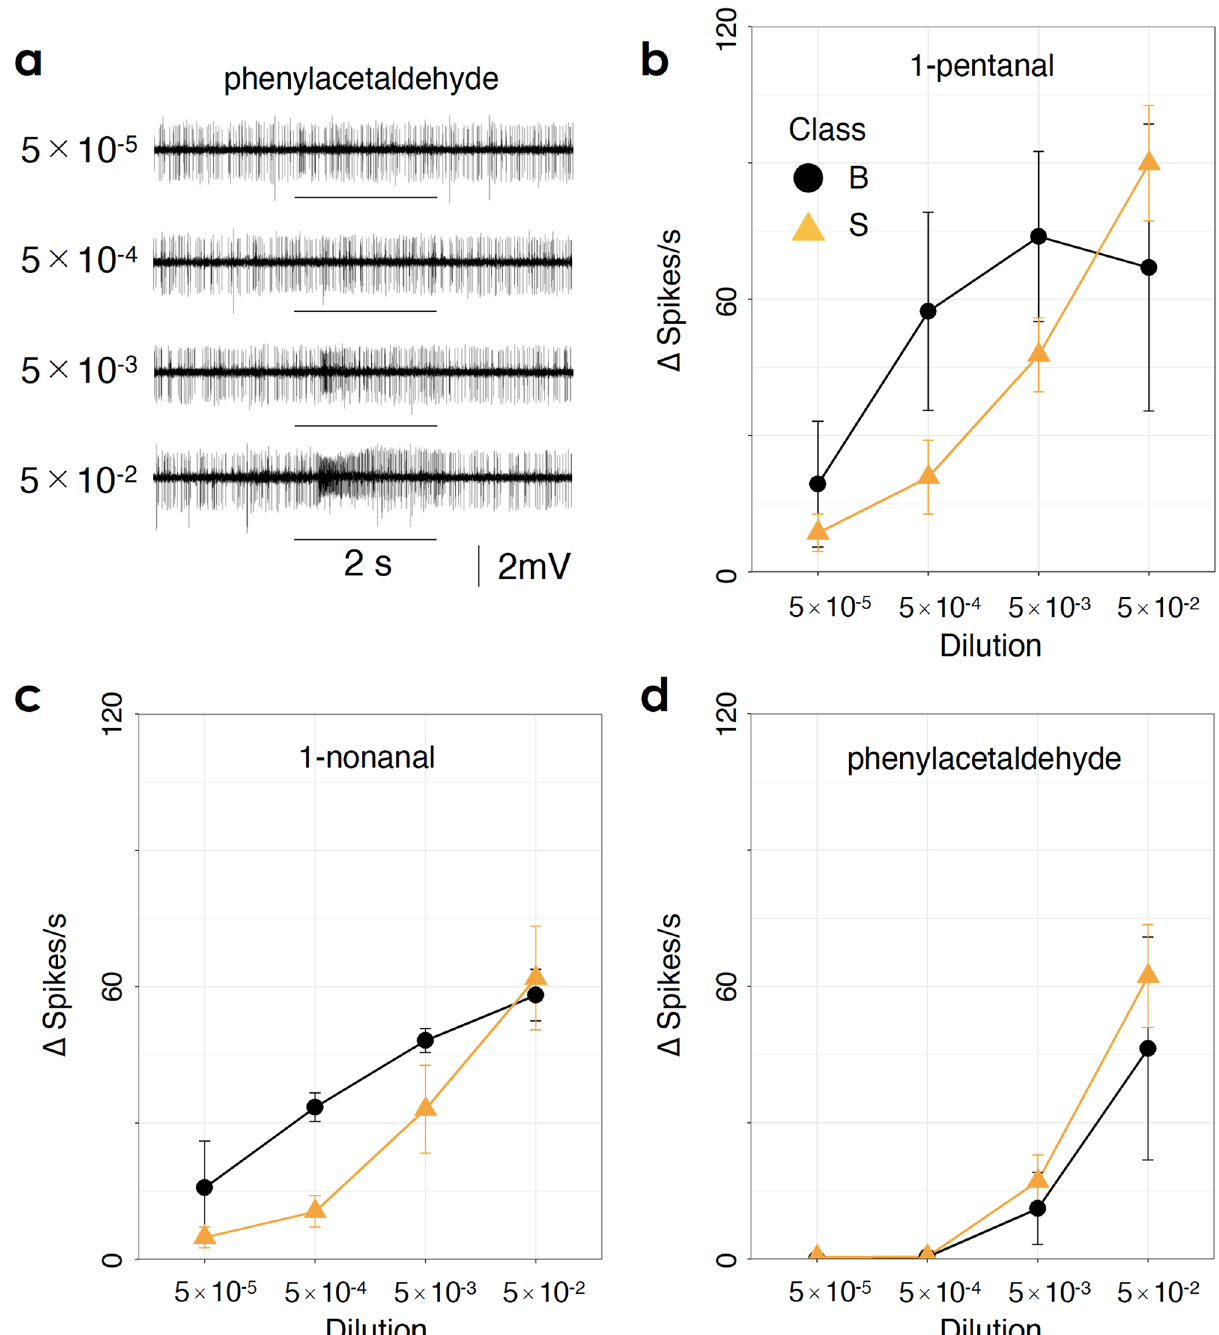
Figure 4. ( a ) Sample responses to phenylacetaldehyde at dilutions from 5 × 10 −5 to 5 × 10 −2 . Sample responses were recorded from the same basiconic sensillum. Black bars under recordings indicate the period of odour stimulation (2 s). ( b – d ) Dose–response curves for OSNs (unit 3) to 1-pentanal ( b ), 1-nonanal ( c ), and phenylacetaldehyde ( d ). Responses to aldehydes suggested that seven OSNs belonged to class S (orange triangle) and that three OSNs belonged to class B (black circle). The mean response and standard error for each class are plotted against the